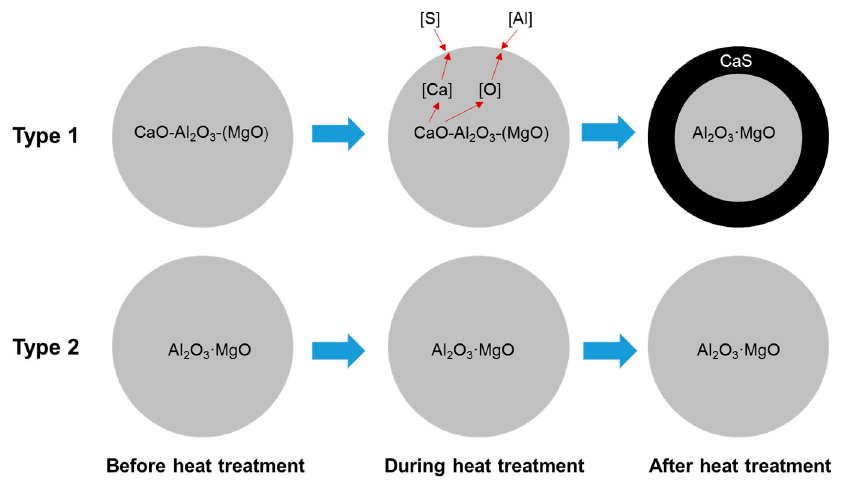
Figure22. Figure 22. Schematic of the transformation mechanism of inclusions in the bearing during heat treatment.